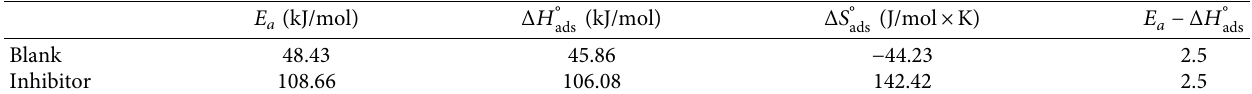
Table 6: Activation data of SS dissolution in 1M H